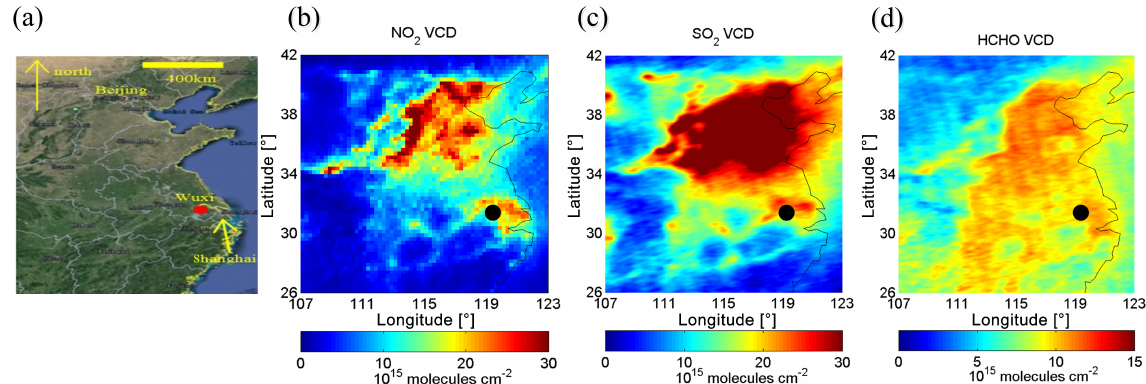
Figure 1. Wuxi city, in which the MAX-DOAS instrument is operated, is marked by the red dot in (a) . Panels (b) , (c) and (d) show maps of the averaged tropospheric VCDs of NO 2 from DOMINO 2, SO 2 and HCHO from BIRA, derived from OMI observations over eastern China in the period from 2011 to 2014, respectively. The black dots indicate the location of